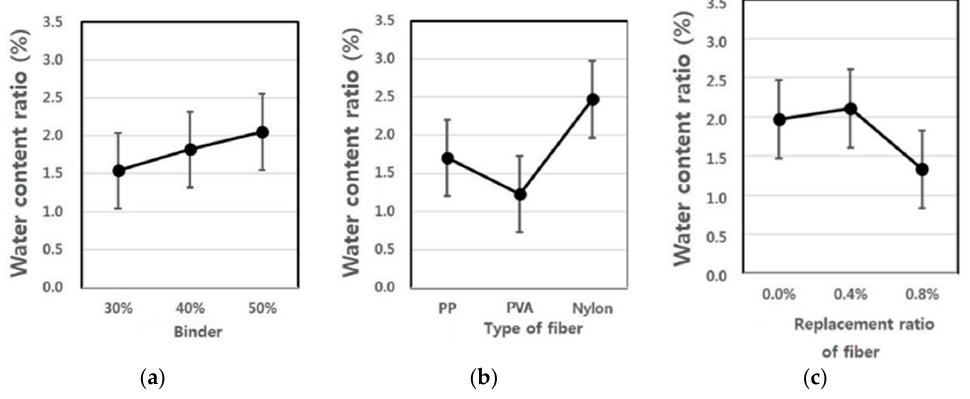
Figure 4. Assumed moisture content ratio of extrusion panel by variance analysis: ( a ) replacement ratio of binder; ( b ) type of fiber; ( c ) replacement ratio of fiber.